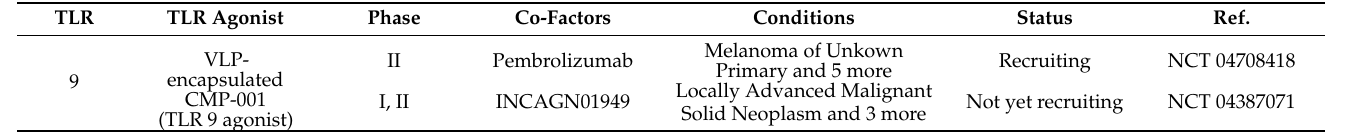
Table 5. Current clinical trials of TLR agonists using VLP delivery